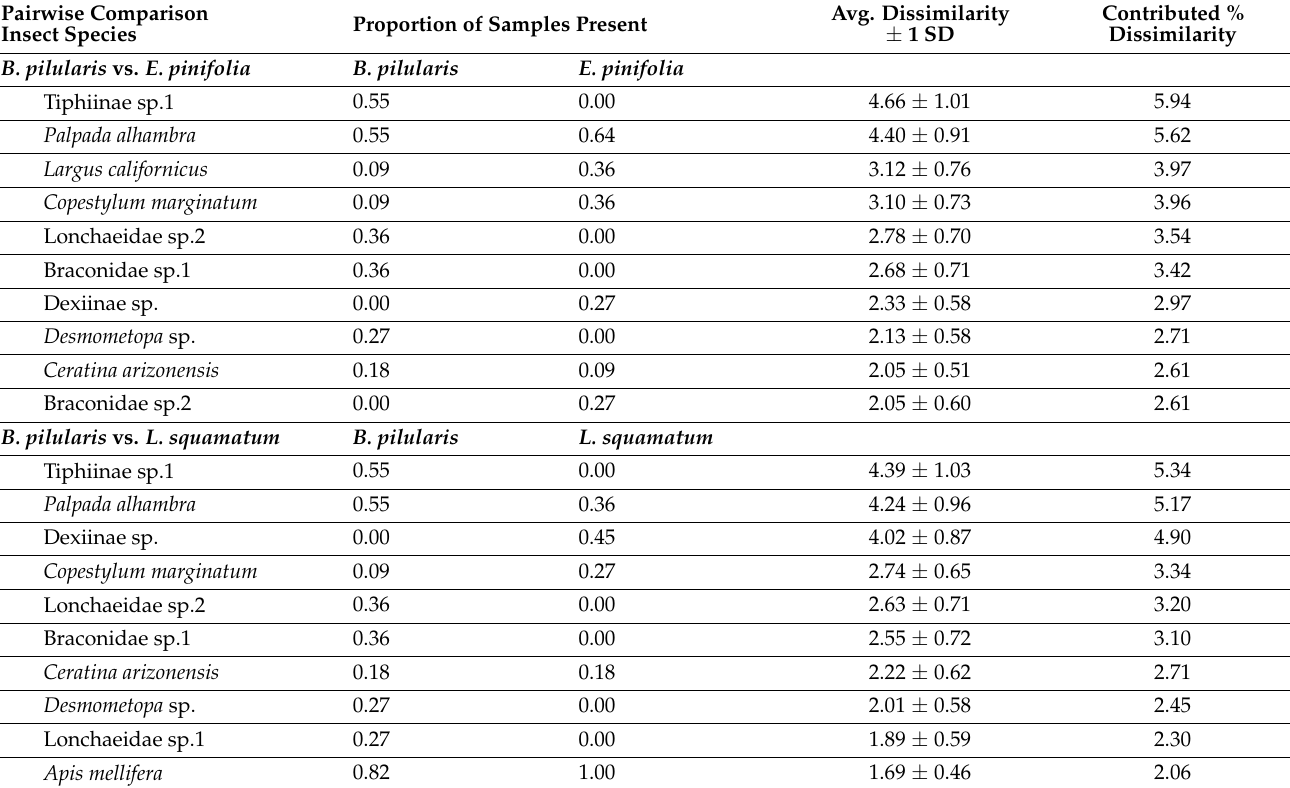
Figure 2. MDS ordination showing the relationship among the flower-visiting insect compositions (presence absence of different species) on the three fall-blooming shrubs. Closed shapes represent samples taken in the morning, while open shapes show samples from the afternoon. Similarity was determined using the Bray – Curtis similarity coefficient. Samples that are closer together are more similar in terms of species composition. Table 10. Results from pair-wise SIMPER analyses of samples, listing the ten most important species according to their contribution to the dissimilarity between shrubs.